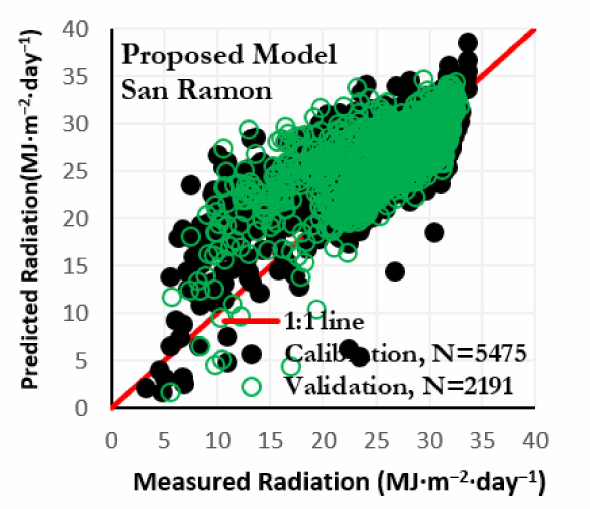
Figure 13. Solar radiation estimated by proposed model at San Ramon station versus measured values in calibration and validation sets. Table 20. RMSE values (J · cm − 2 · day − 1 ) and number of data points belonging to under- and